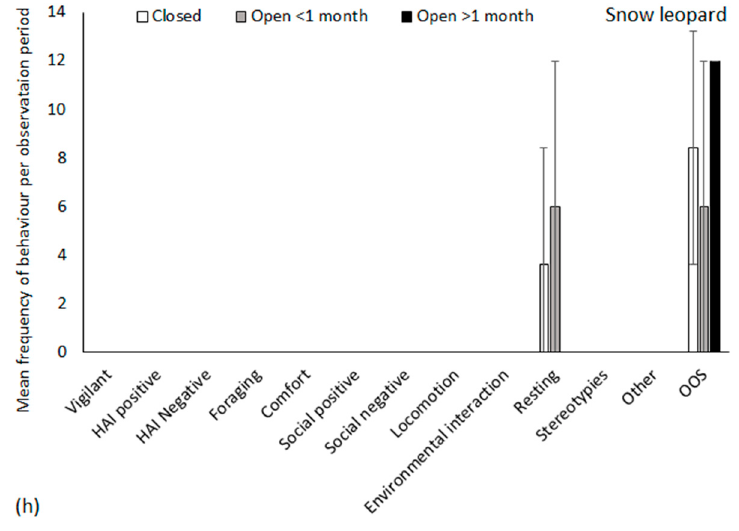
Figure 1. ( a–h ) An overview of behaviour in the study species during facility closure, the first month post-reopening and more than one-month post reopening. Mean values are based on frequency of behaviour performed by the study group per five-minute observation period. Maximum frequency of observations was six per five-minute period for Chapman’s zebra, nyala, Rothschild’s giraffe, Chinese goral and swamp wallaby. Maximum frequency of observations was 12 per five-minute period for Grevy’s zebra and snow leopard and 18 per five-minute period for Amur leopard. Error bars represent standard deviation.